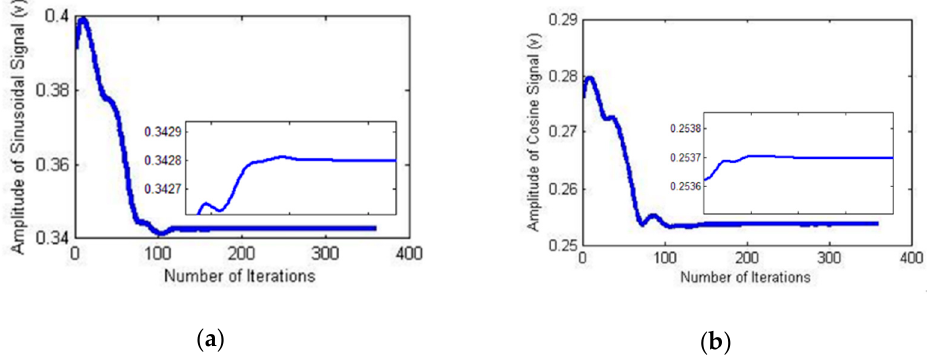
Figure 8. Estimation process. ( a ) Amplitude of the sine signal; ( b ) amplitude of the cosine signal.